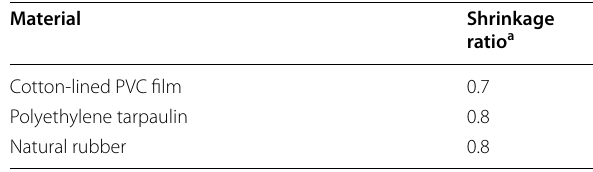
Table 1 Thickness, Young’s modulus, and bending stiffness of each material